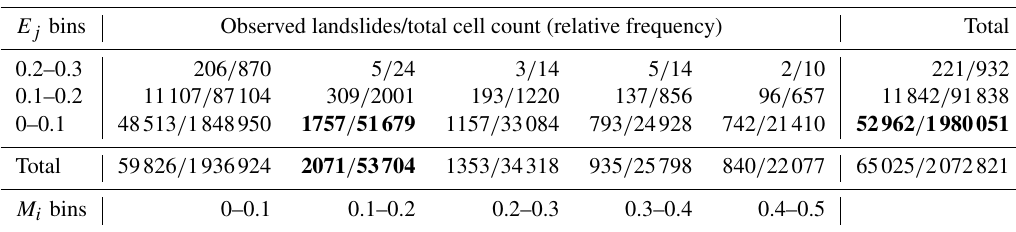
Table 1. Hypothetical example of calculating relative frequency, weight, and P (LS) during model integration using the above data is shown in bold.